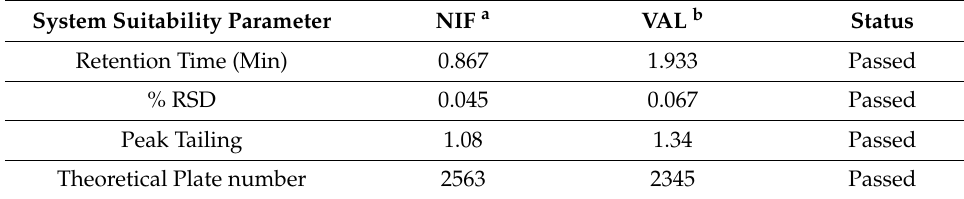
Table 4. Systems suitability parameters of NIF and